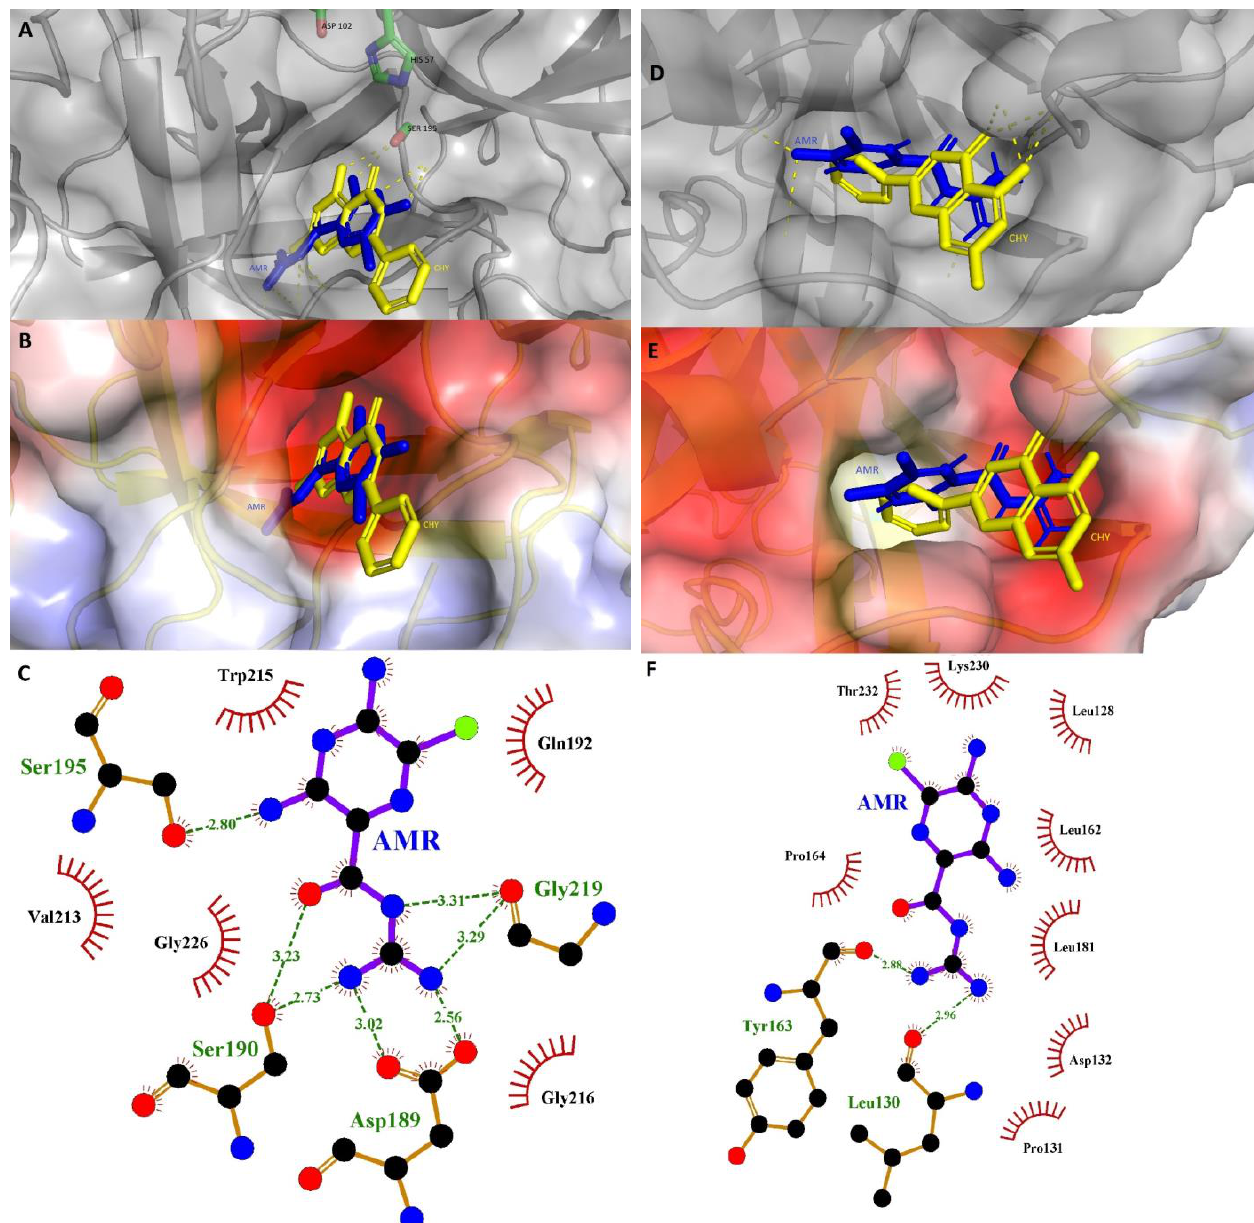
Fig. 2. A: uPA is shown as semitransparent surface, with amiloride (dark blue) and chrysin (yellow) docked in the specificity pocket, and amino acids of catalytic triad shown as stick model, colored: green - carbon, blue - nitrogen, red - oxygen. B: uPA surface colored by electrostatic potential: red negative (-5 k b T/e c ), blue - positive (+5 k b T/e c ), where: k b is Boltzmann’s constant, T is temperature in K, e c is the charge of an electron. Inhibitors of uPA in the specificity pocket are shown as in A. C: Key amino acids of the specificity pocket interacting with amiloride by Ligand Plot. D: tPA is shown as semitransparent surface, with amiloride (dark blue) and chrysin (yellow) docked in the Leu128-Pro131 loop. E: tPA surface colored by electrostatic potential as in B. F: Key amino acid of Leu128-Pro131 pocket interacting with amiloride by Ligand